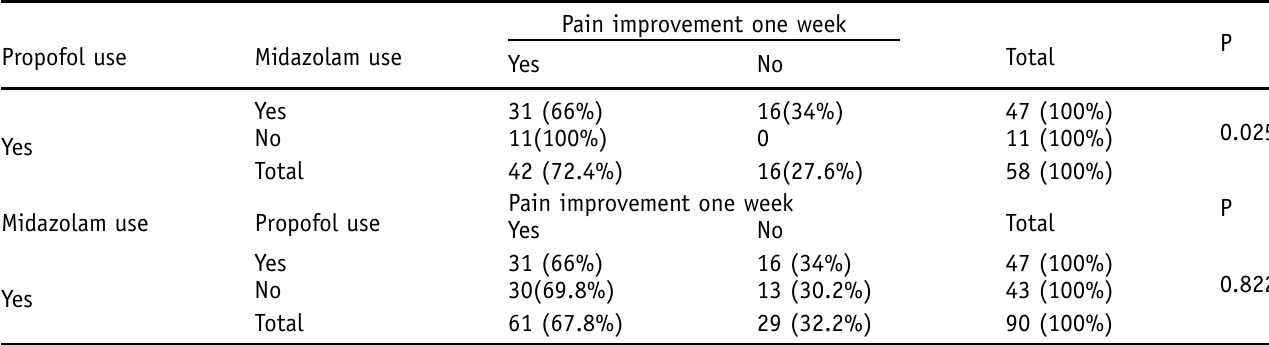
Table I. Relationship between pain improvement and the use of propofol with or without midazolam and the use of midazolam with or without propofol during sedation at one week postarthrocentesis.